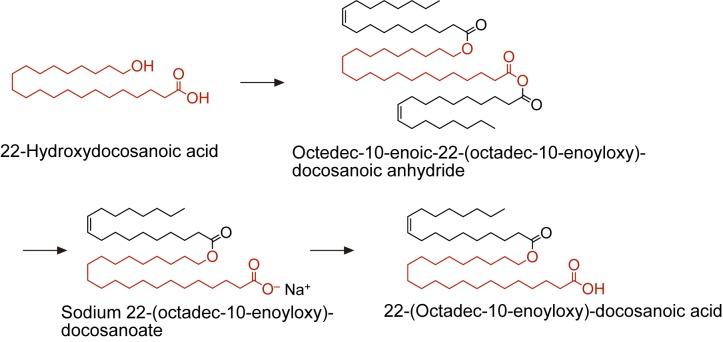
Synthesis scheme of OAHFA ([O-C18:1]-ω-OH C22:0 FA).